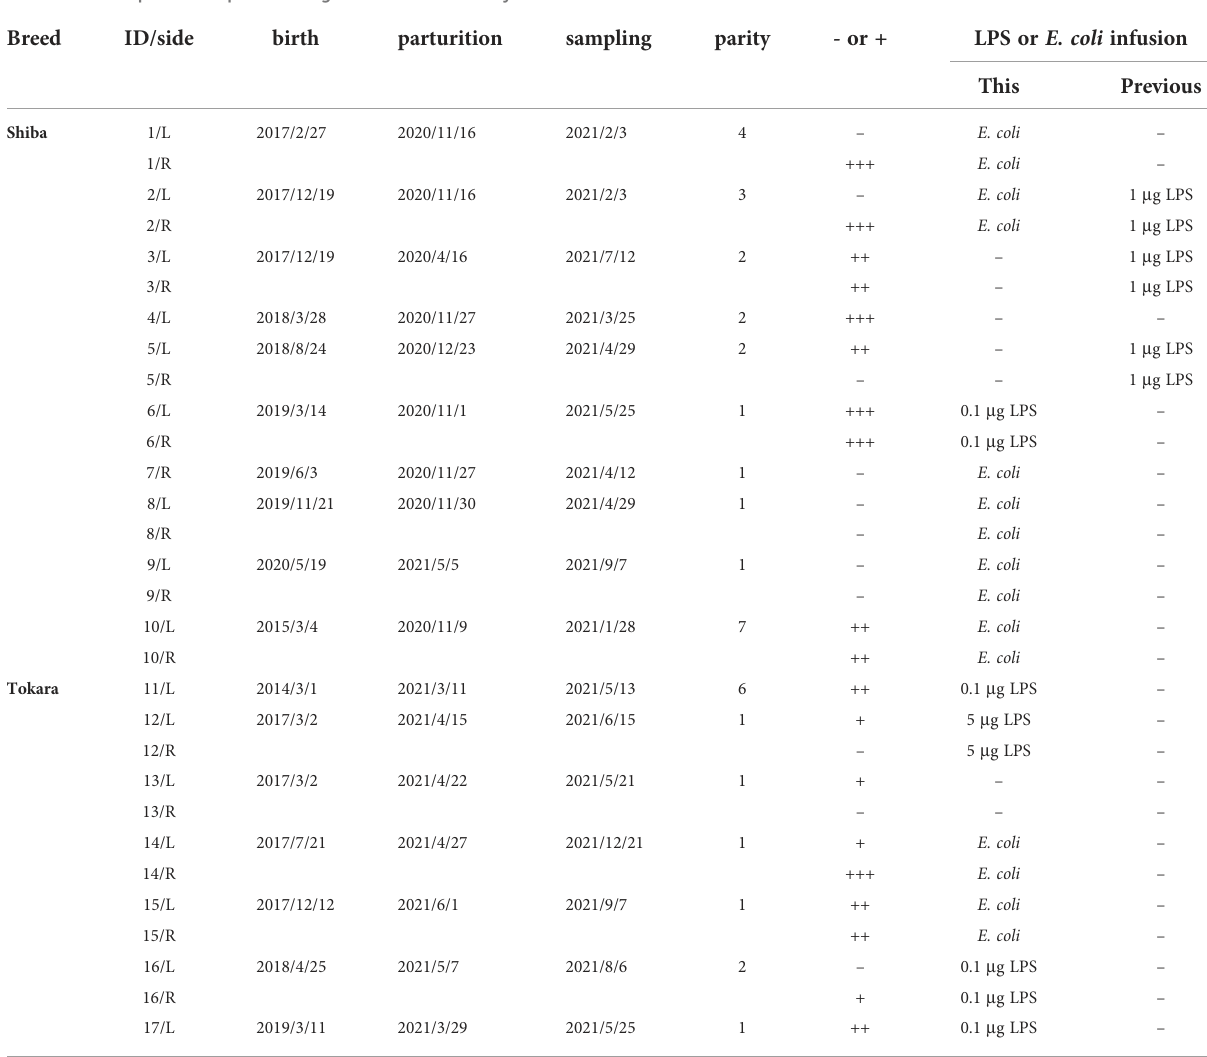
TABLE 1 Description of experimental goats used in the study. Breed ID/side birth parturition